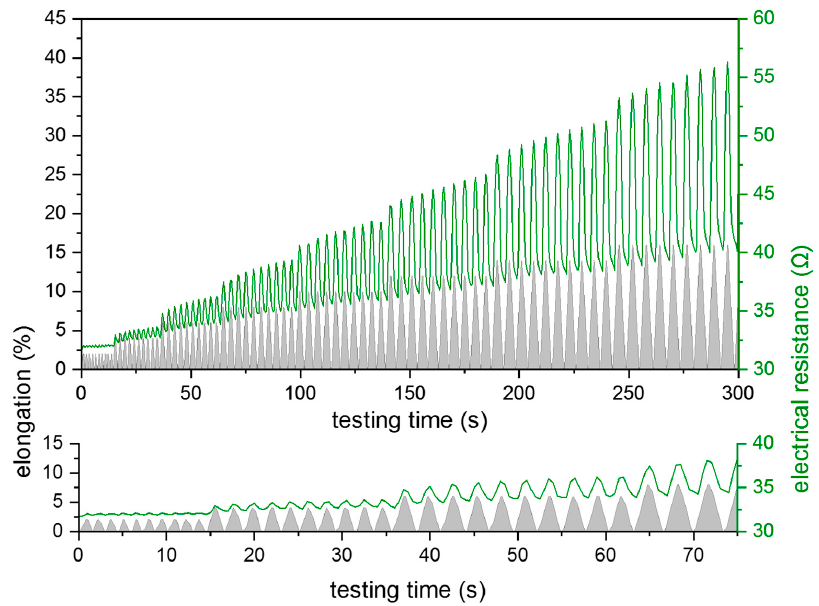
Figure 14. Investigation of the functionality of an embroidered strain sensor, placed in the weld seam of a textile membrane sample (diagrams below: Detailed view of the first 75 s of the experiment).